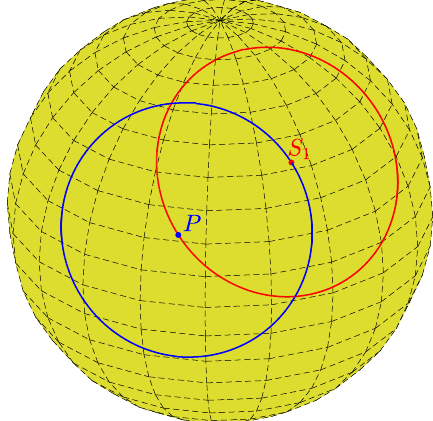
Figure 2. Each primary point (blue point P ) defines a primary circle of radius r (blue). Each secondary point, such as the red point S 1 on the primary circle, defines a secondary circle of radius r (red) passing through the primary